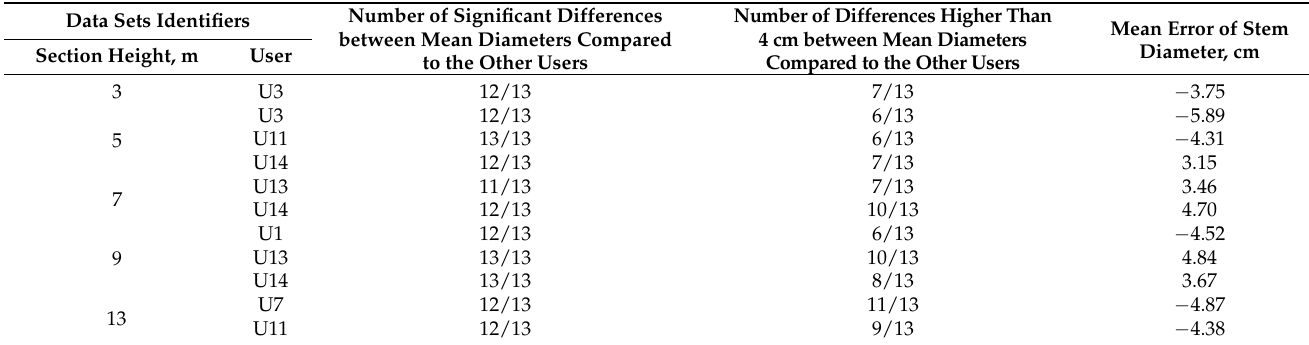
Table 3. Abnormal data sets of stem diameters taken using laser